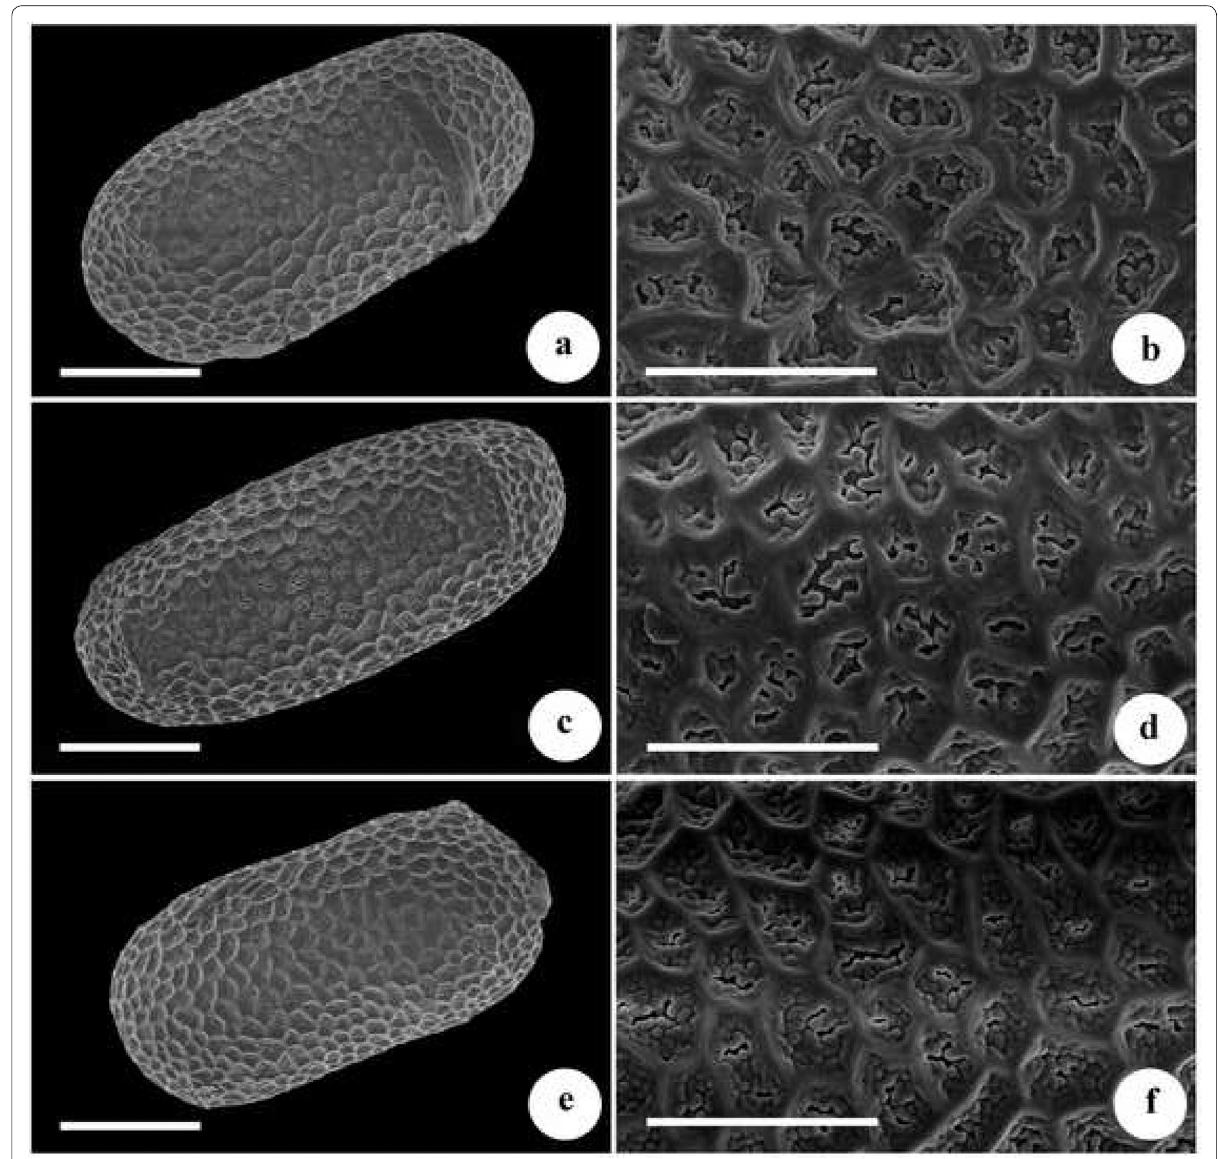
Fig. 1 Micromorphology of pollen grains of Impatiens wuyiensis , I. platysepala and I. chloroxantha . a, b I. wuyiensis ; c, d I. platysepala ; e, f I. chloroxantha . a, c, e overview of pollen grain (scale bar: 10 μm); b, d, f sexine sculpture (scale bar: 5